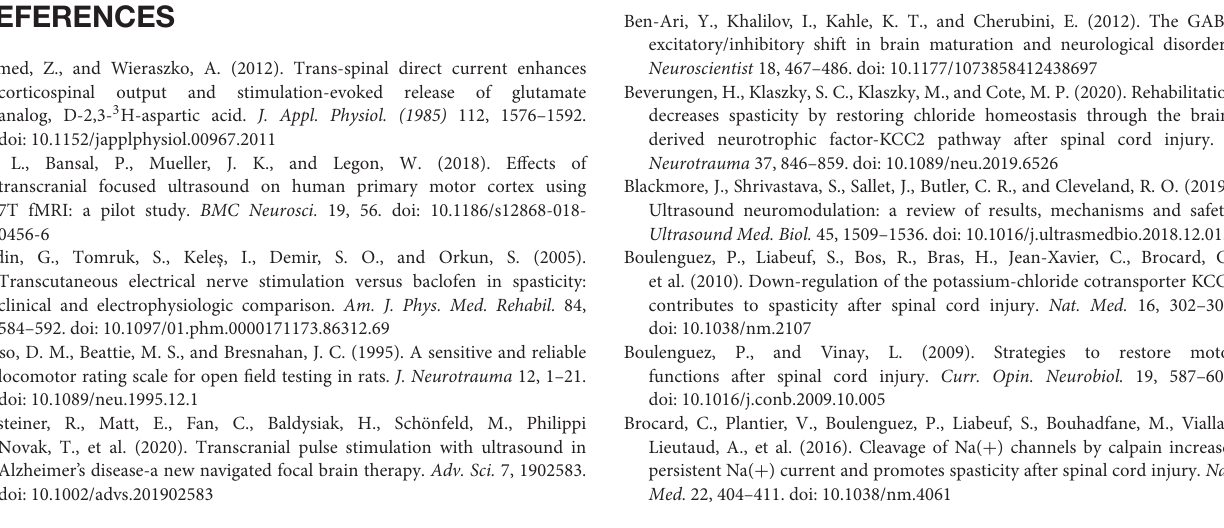
(related to the Figure 2 sham group), LIFU − stimulation for the sham operation rats (related to the Figure 2 LIFU − group), and LIFU + stimulation in the spinal cord injury (SCI) rats (related to the Figure 2 LIFU +